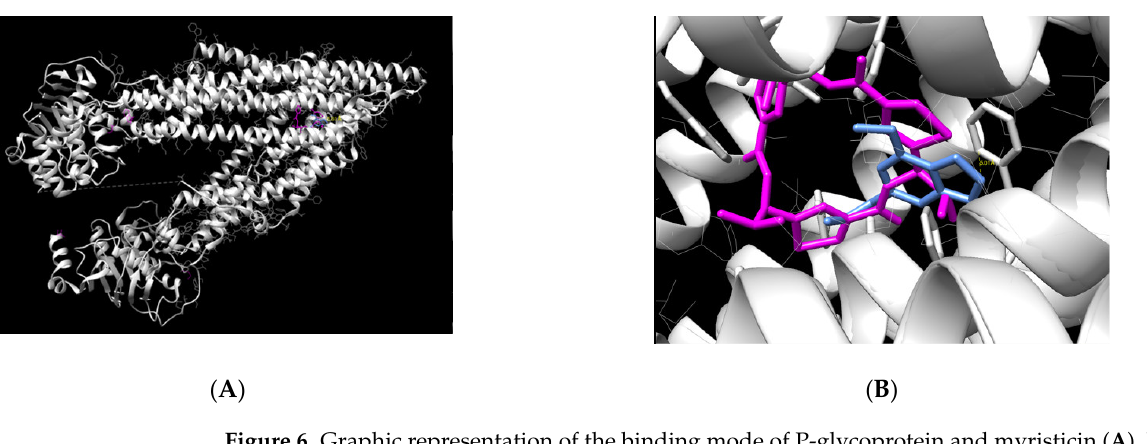
Figure 6. Graphic representation of the binding mode of P-glycoprotein and myristicin ( A ). Detail of the protein showing its sites occupied by myristicin and the natural ligand ( B ). The ligands are represented by pink (natural ligand) and blue (myristicin); P-gp is represented bygray. The chemical name of the ligand is (4R,11R,18R)-4,11,18-tri(propan-2-yl)-6,13,20-triselena-3,10,17,22,23,24-hexaazatetracyclo[17.2.1.1~5,8~.1~12,15~]tetracosa-1(21),5(24),7,12(23),14,19(22)-hexaene-2,9,16-trione.). Through the UCSF Chimera program, it was